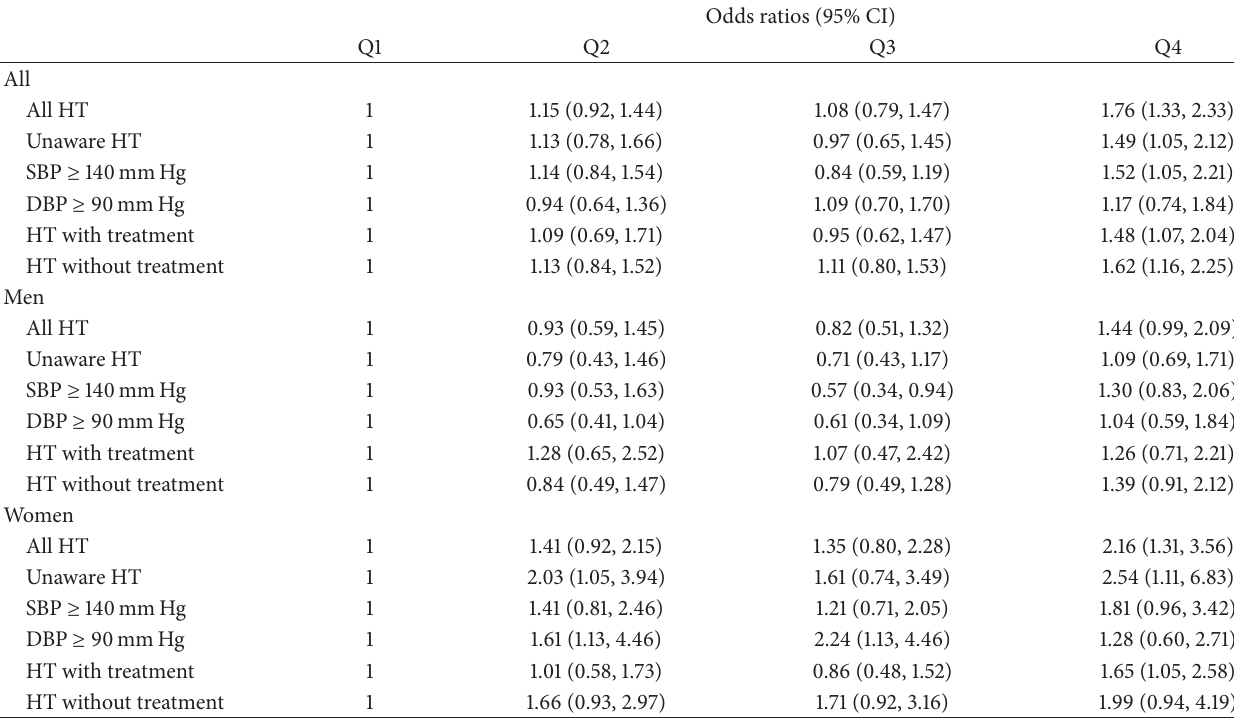
Table 5: Adjusted odds ratios for high blood pressure according to quartile of serum